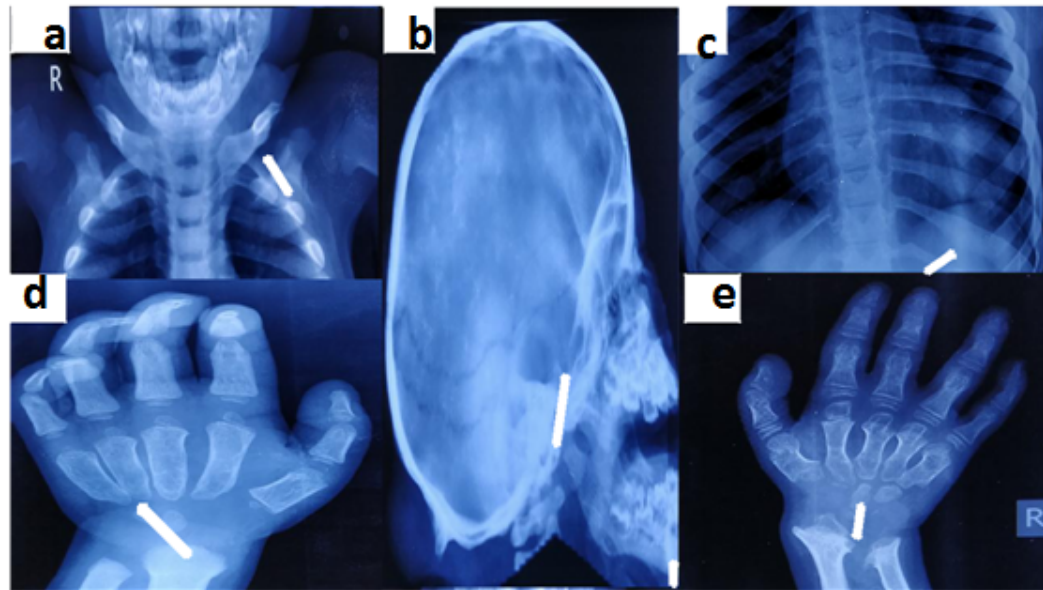
Figure 4. Dysostosis multiplex involving skull, ribs, clavicle and hands A – short and thick clavicles, B – J-shaped sella, C –Oar shaped ribs, D – Proximal tapering of metacarpals, E - V shaped distal ulna and radius.